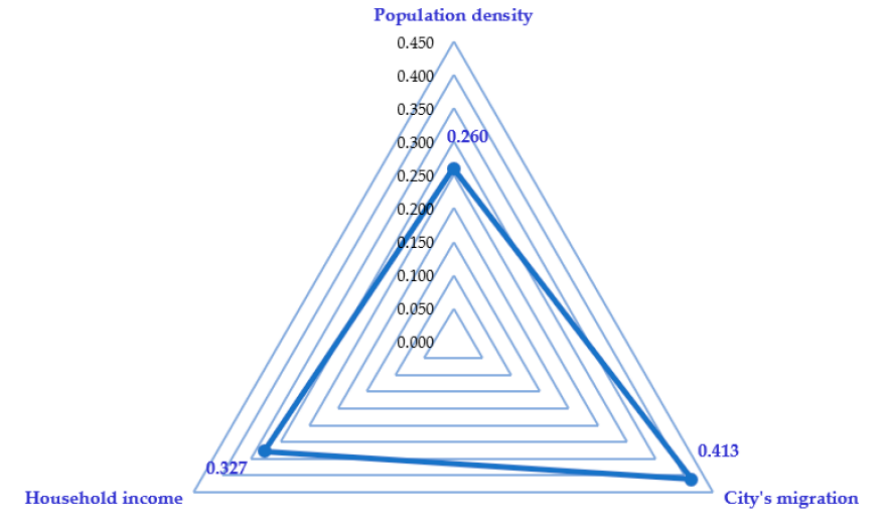
Figure 6. Relative weights of the assessment indicators for “Demography”.